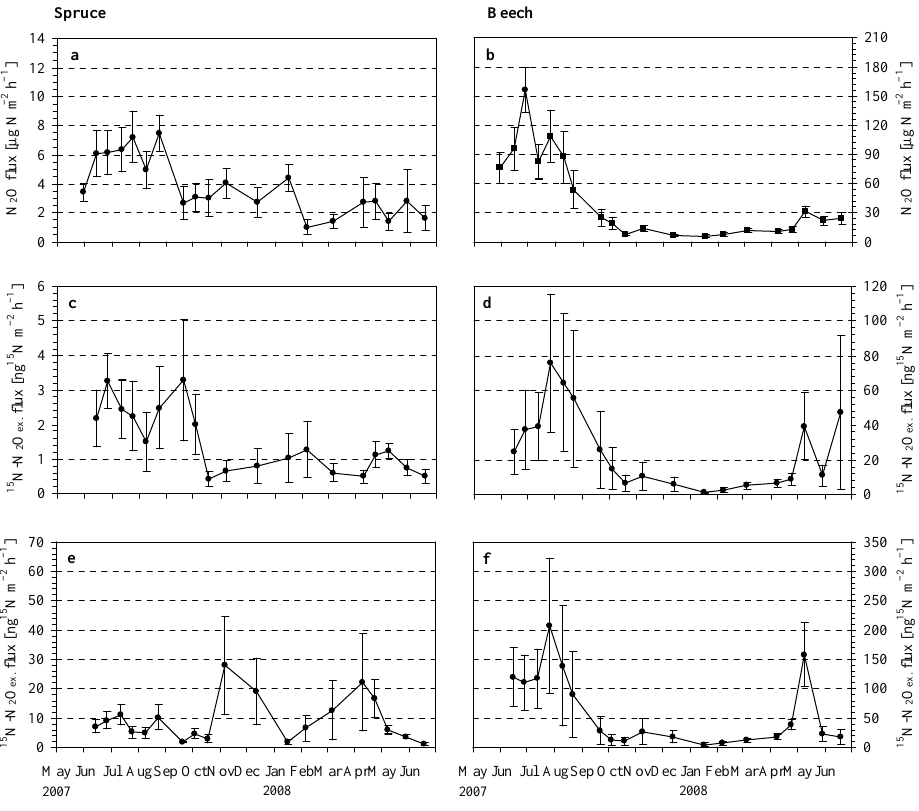
Fig. 1. Mean ( ± SE, n = 13) N 2 O fluxes (a, b) and mean ( ± SE, n = 5) 15 N-N 2 O excess fluxes of the NH + Figure 1. Mean (± SE, n = 13) N 2 O fluxes (a, b) and mean (± SE, n = 5) 15 N-N 2 O excess 733 NH 4 NO 3 (double)-labelled treatments (e, f) of the spruce stand (a, c, e) and beech stand (b, d, f) . Please note the different scales. fluxes of the NH 4+ -labelled treatments (c, d) and NH 4 NO 3 (double)-labelled treatments (e, f) 734 of the spruce stand (a, c, e) and beech stand (b, d, f). Please note the different scales. 735